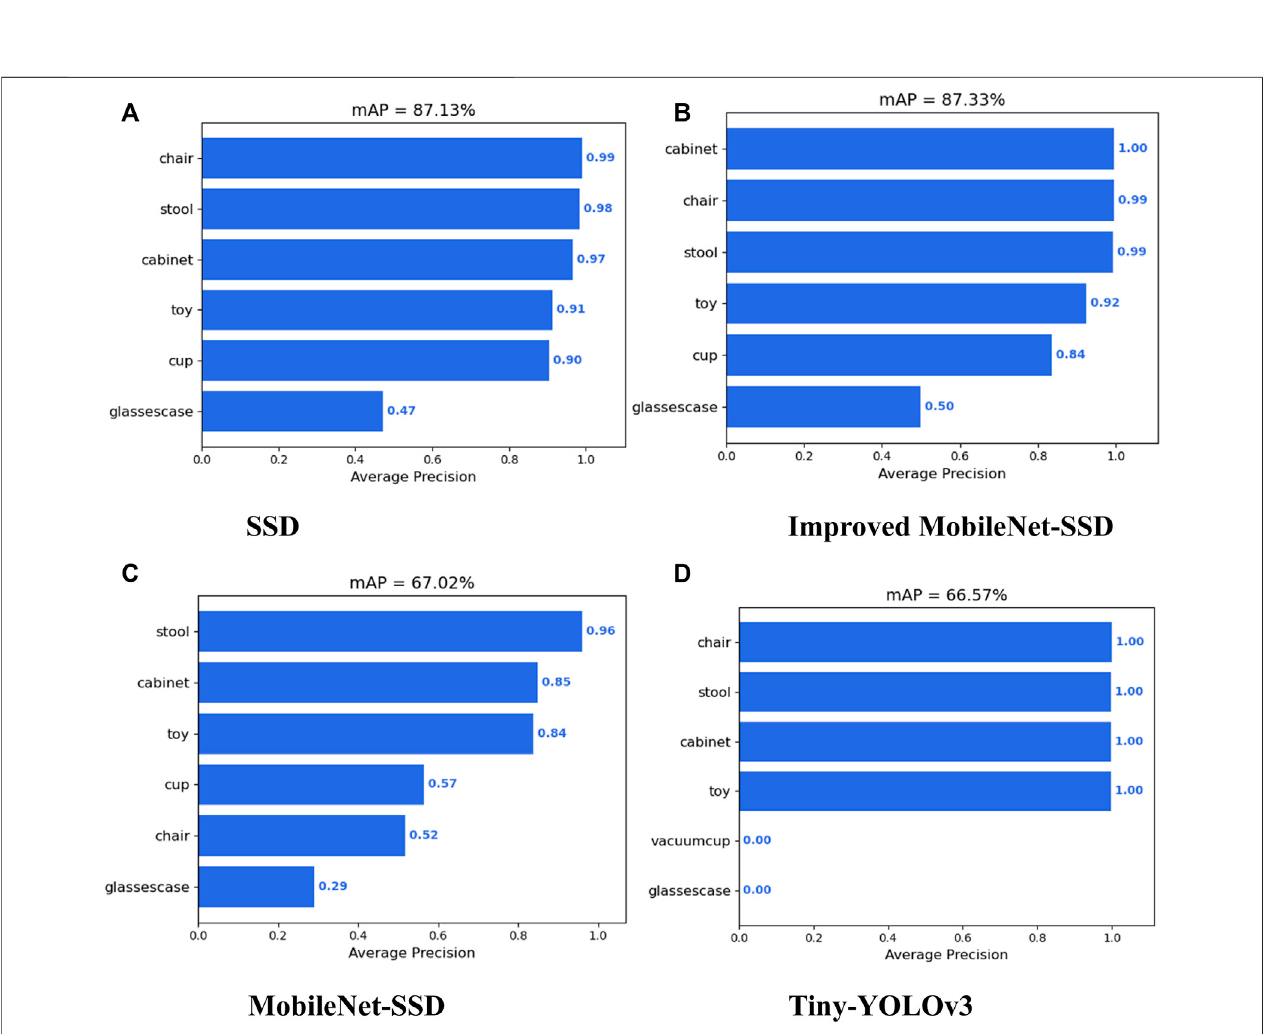
FIGURE 9 | Comparison of detection accuracy between SSD and lightweight target detection algorithms for various classes. (A) SSD. (B) Improved MobileNet- SSD. (C) MobileNet-SSD. (D) Tiny-YOLOv3.